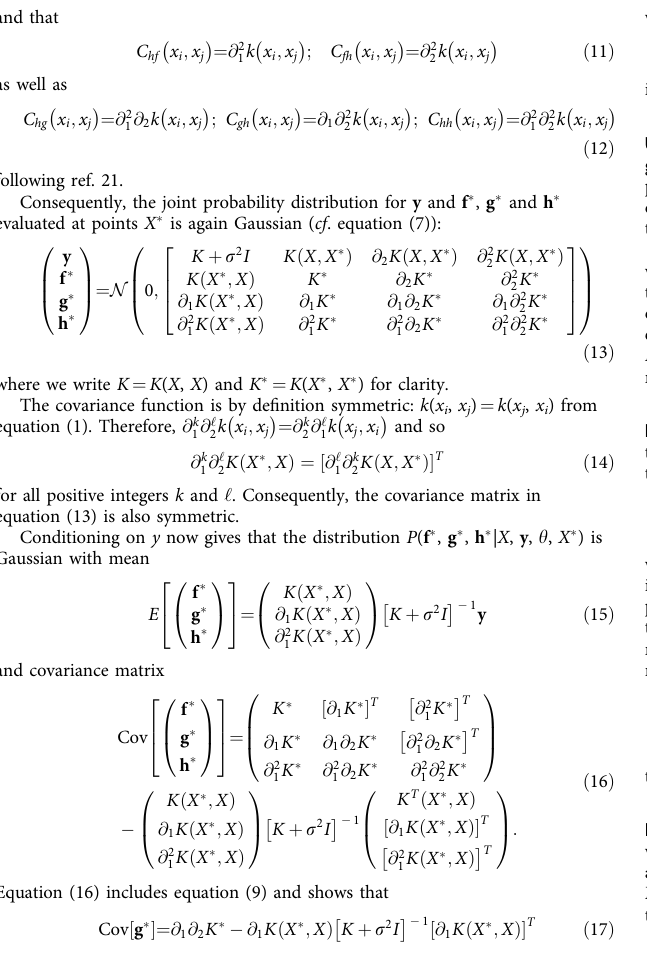
Table 1 | Ranges of hyperparameters used for the examples. Figure Covariance function Hyperparameter Lower bound Upper bound Squared